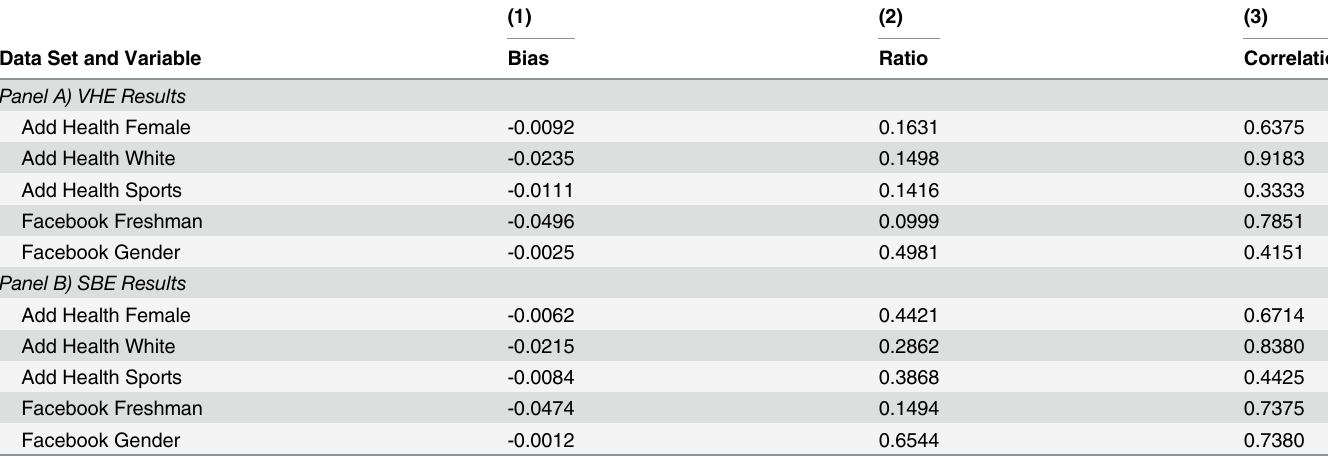
Table 3. Measures of the relationship between VHE and SBE estimates of sampling variance and the population sampling variance.